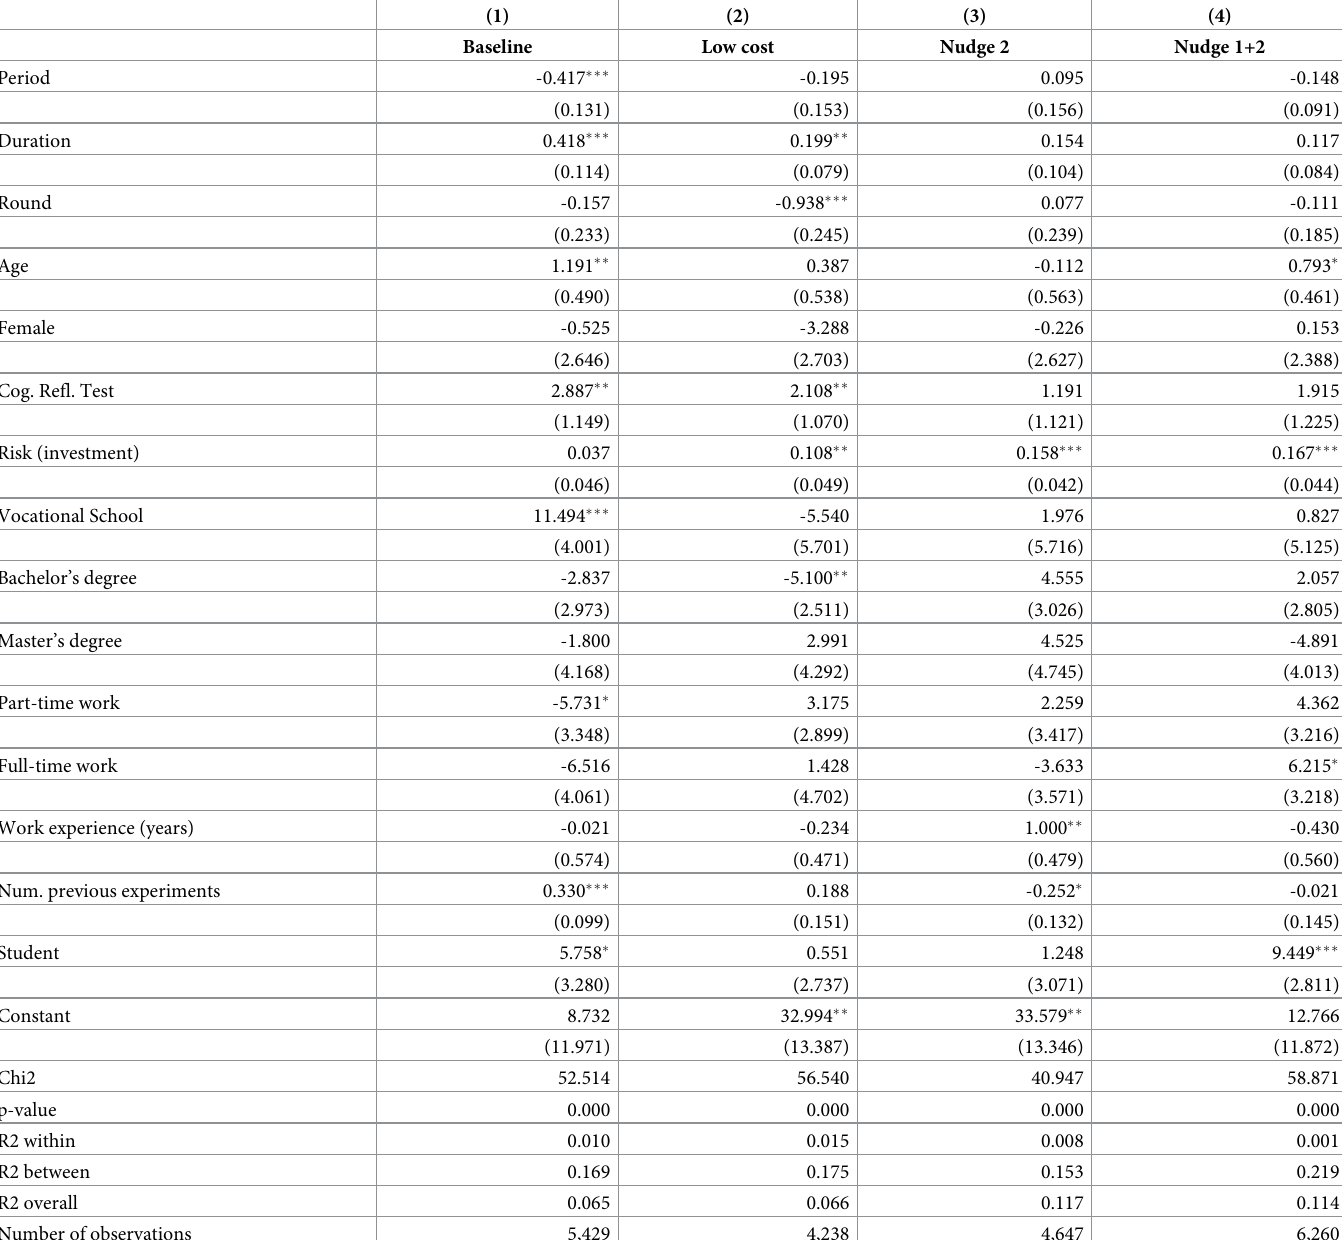
Table 5. The change of reservation wage over the search